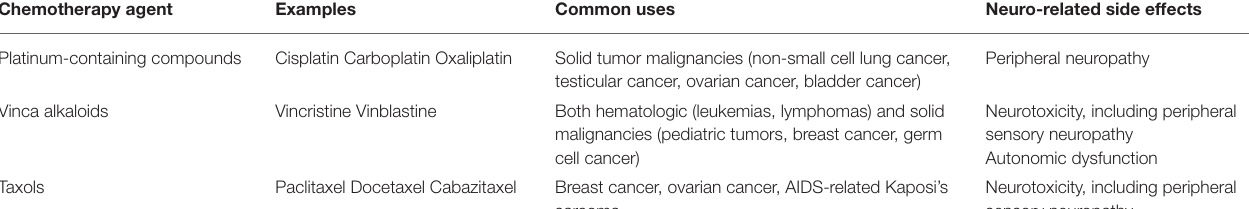
TABLE 1 | Common chemotherapy agents with neuro-related side effects.